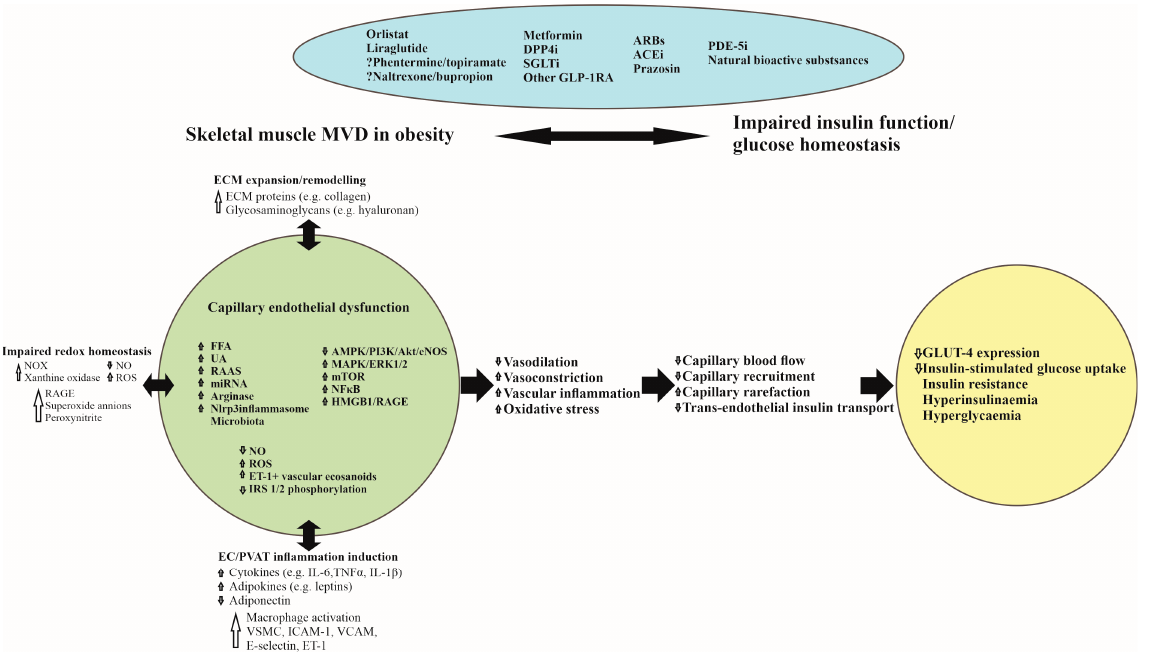
Figure 1. Pathophysiological mechanisms linking skeletal muscle microvascular dysfunction with glucometabolic disorder in obesity and potential therapeutic agents. ACEi, Angiotensin-Converting Enzyme inhibitors; AMPK 5’-, Adenosine Monophosphate-activated Protein Kinase; ARBs, Angiotensin Receptor Blockers; Akt, Protein Kinase B; DPP4i, Dipeptidyl-Peptidase-4 inhibitors; EC, Endothelial Cell; ECM, Extracellular Matrix; eNOS, endothelial Nitric Oxide Synthase; ERK, Extracellular-signal-regulated Kinase; ET-1, Endothelin 1; FFA, Free Fatty Acids; GLP-1RA, Glucagon-like Peptide-1 Receptor Agonists; GLUT-4, Glucose Transporter 4; HMGB 1, High Mobility Group Box chromosomal protein 1; IRS, Insulin Receptor Substrate; ICAM1, Intercellular Adhesion Molecule 1; IL-1 β , Interleukin-1Beta; IL-6, Interleukin-6; MAPK, Mitogen-Activated Protein Kinase; miRNAs, Micro RNAs; mTOR, Mammalian Target of Rapamycin; MVD, Microvascular Dysfunction; NF- κ B, Nuclear Factor-Kappa B; NO , Nitric Oxide; NOX , Nicotinamide Adenine Dinucleotide Phosphate (NADPH) Oxidase; PDE-5i, Phosphodiesterase-5 inhibitors; PI3K, Phosphatidylinositol 3 Kinase; RAAS, Renin-Angiotensin-Aldosterone System; ROS, Reactive Oxygen Species; RAGE, Receptor for Advanced Glycation End products; SGLT2i, Sodium Glucose co-Transporter 2 inhibitors; TNF- α , Tumour Necrosis Factor-alpha; UA, Uric Acid; VCAM1, Vascular Cell Adhesion Molecule 1; VSMC, Vascular Smooth Muscle Cells.